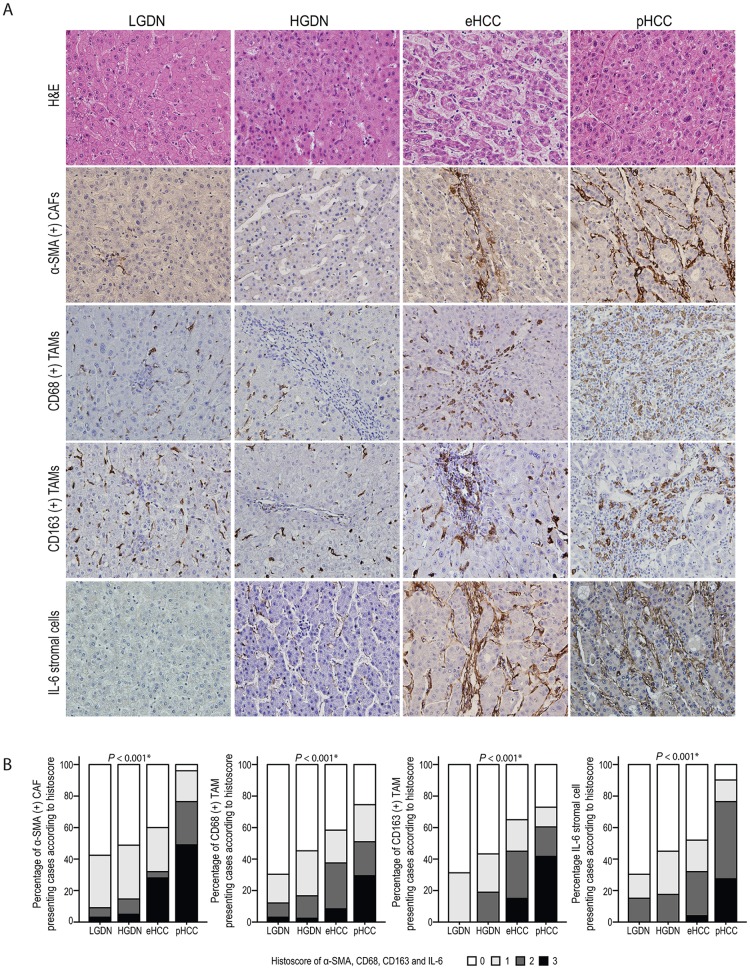
The alteration of tumor stromal cells in B viral multistep hepatocarcinogenesis.A) Representative features of α-SMA (+) CAFs, CD68 (+) TAMs, CD163 (+) TAMs, and IL-6 (+) stromal cells in LGDNs, HGDNs, eHCCs, and pHCCs are presented. Original magnification x200. B) Bar charts indicate the percentage of cases expressing α-SMA (+) CAFs, CD68 (+) TAMs, CD163 (+) TAMs, and IL-6 (+) stromal cells in B viral multistep hepatocarcinogenesis. *Statistical significance (P <0.05).